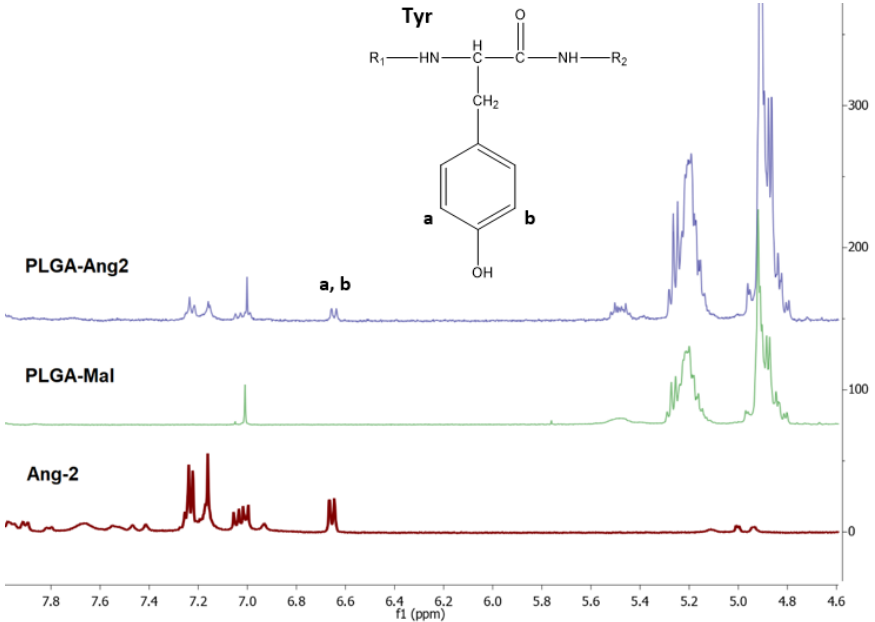
Figure 3. 1 H-NMR spectra of PLGA-Mal, Ang–2, and PLGA-Ang2 obtained in deuterated DMSO.